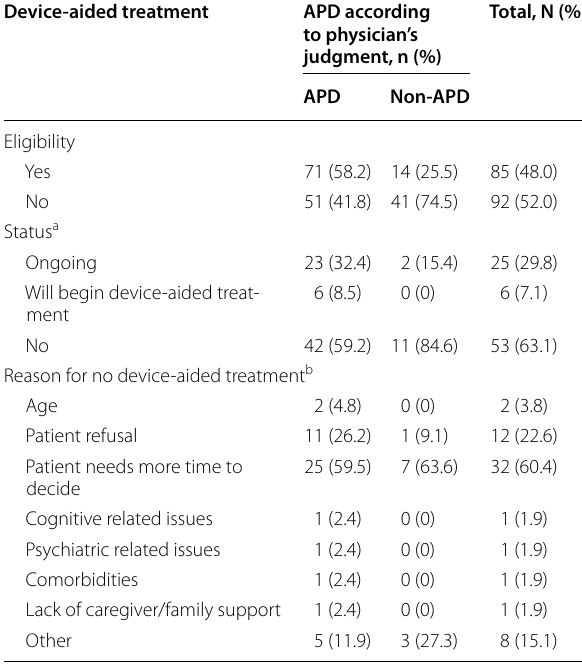
Table 2 Device-aided treatment in the German